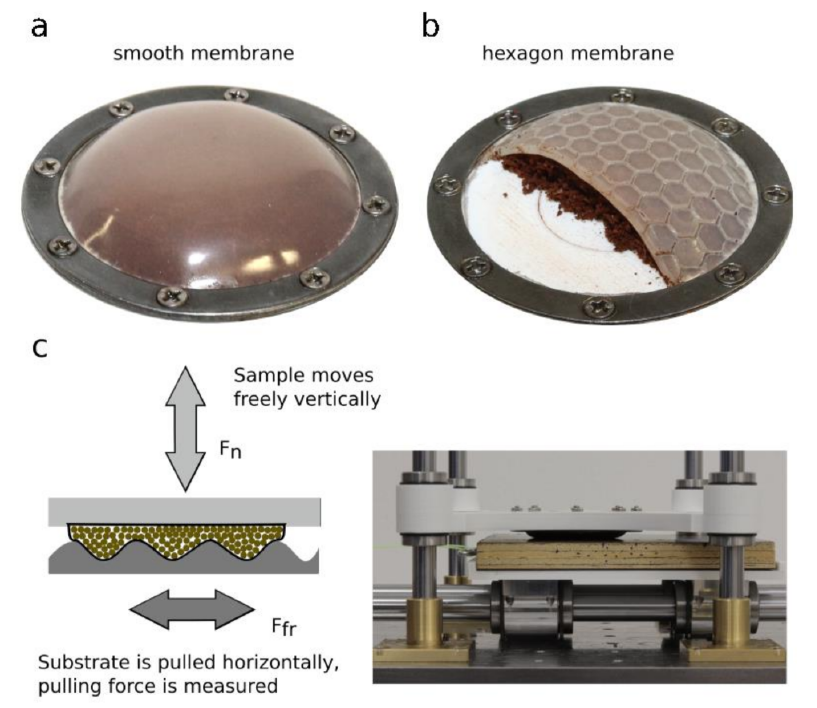
Figure 2. GMFP and experimental setup. ( a ) Photograph of a GMFP with a smooth mem- brane, ( b ) photograph of a GMFP with a hexagonally patterned membrane; the membrane is cut open, showing the GMFP’s ground coffee filling, ( c ) schematic representation (left) and photograph (right) of the experimental